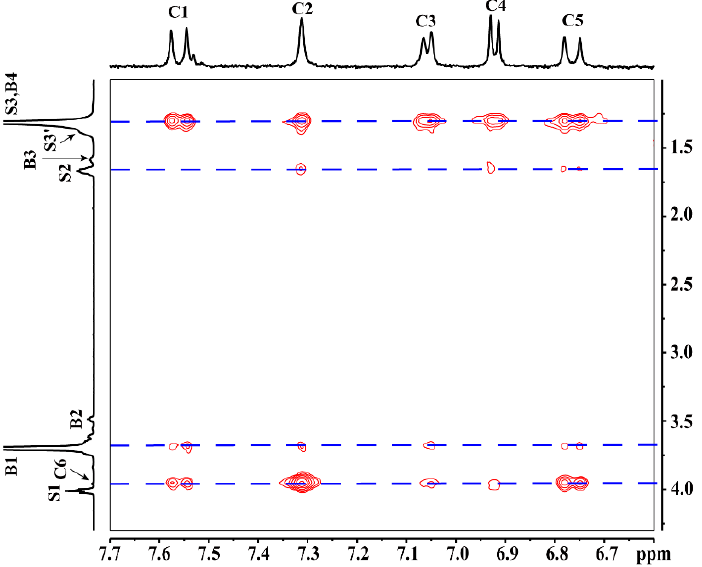
Figure 7. Partially enlarged NOESY spectrum with a mixing time of 0.5 s for α SDS = 0.8 at C T of 40 mM.